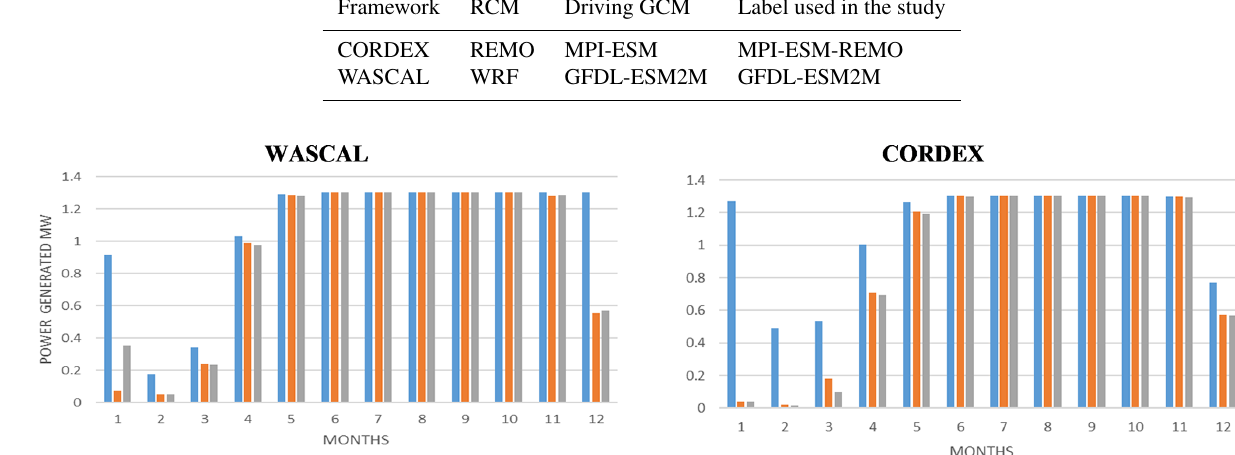
Figure 3. Projected and historical power by WASCAL and CORDEX climate products (corrected data). Blue refers to the reference period (1983–2005), orange is the future period of 2020–2049, and grey represents the future period 2070–2099.